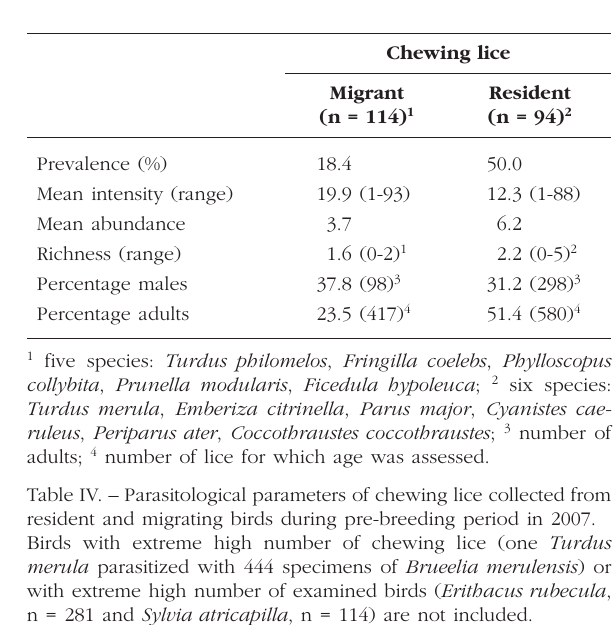
on Coccothraustes coccothraustes , n = 11). Prevalence